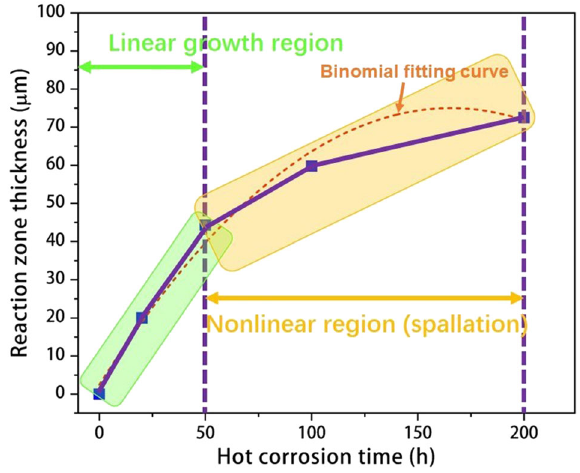
Fig. 1 The thickness of the reaction layer varies with time. The relationship between the thickness of the reaction layer and the hot corrosion time of the alloy sample.